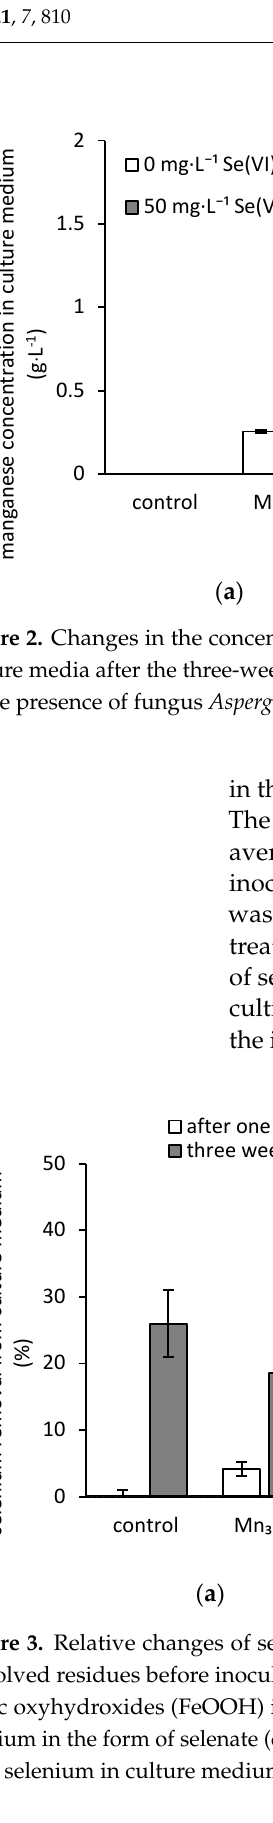
Figure 3. Relative changes of selenium concentrations in ( a ) culture media and ( b ) residual ferric and manganese non- dissolved residues before inoculation and after the three-week static incubation of hausmannite (Mn 3 O 4 ) or amorphous ferric oxyhydroxides (FeOOH) in the presence of fungus Aspergillus niger and selenium, which was introduced into the medium in the form of selenate (control represents the treatment without any solid inorganic phases; initial concentration of total selenium in culture medium was 50 mg ⋅ L − 1 ).